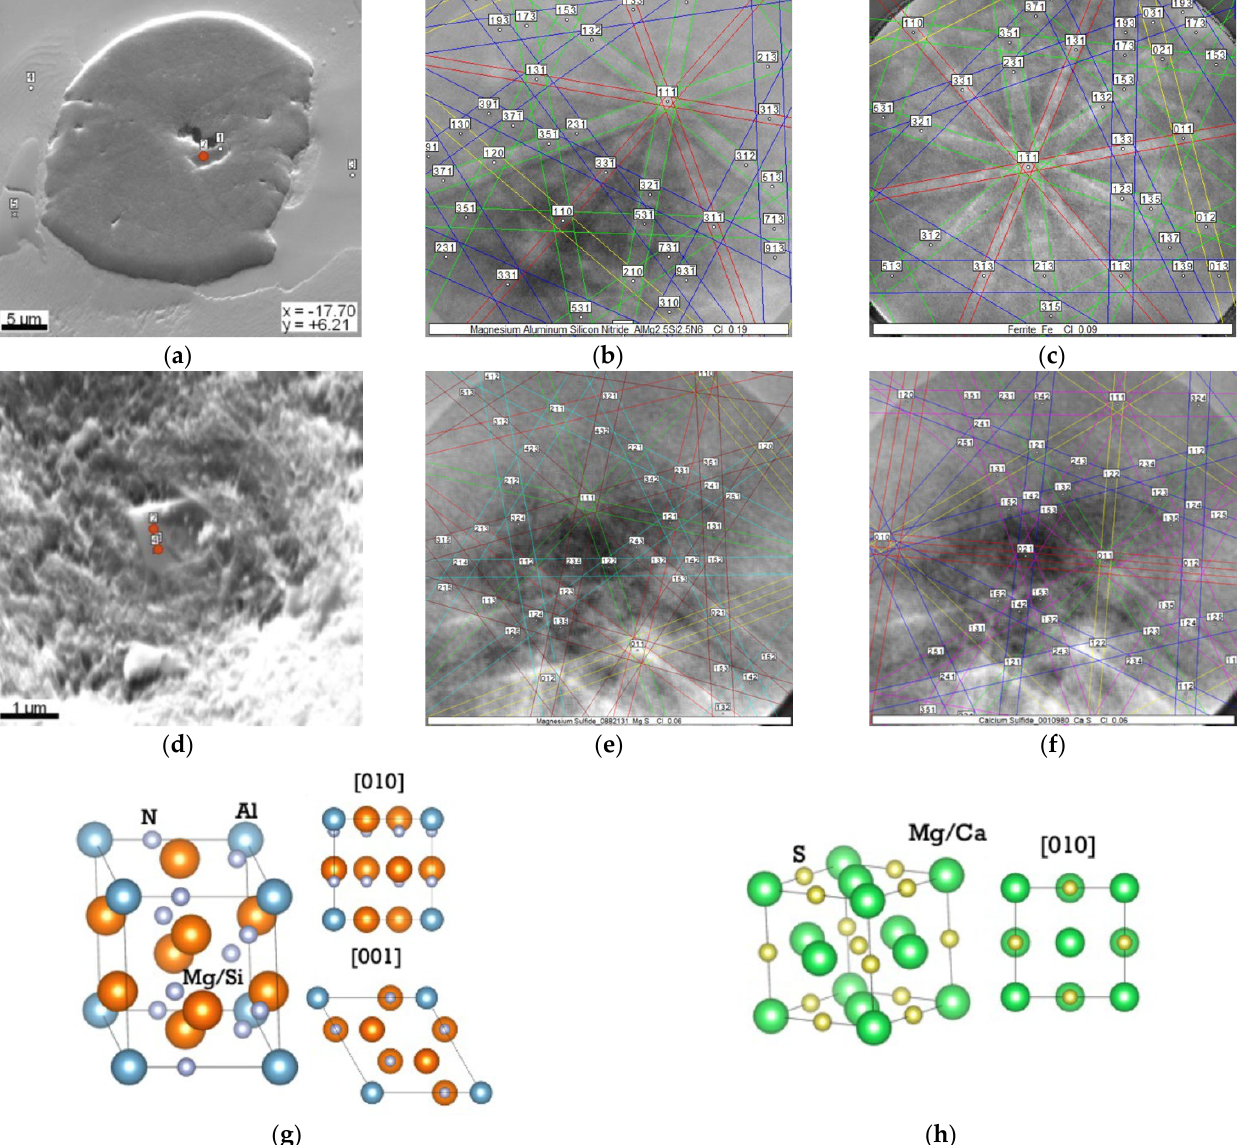
Figure 8. EBSD analysis of microparticles was present in SEM images of Figure 7. The secondary electron images ( a , d ) show the EBSD point of analysis, the ( b , d – f ) the Kikuchi pattern indexed as AlMg 2.5 Si 2.5 N 6 , ( c ) ferrite matrix, and MgS or CaS and ( g , h ) the lattice structure of the complex microparticle phases indexed.